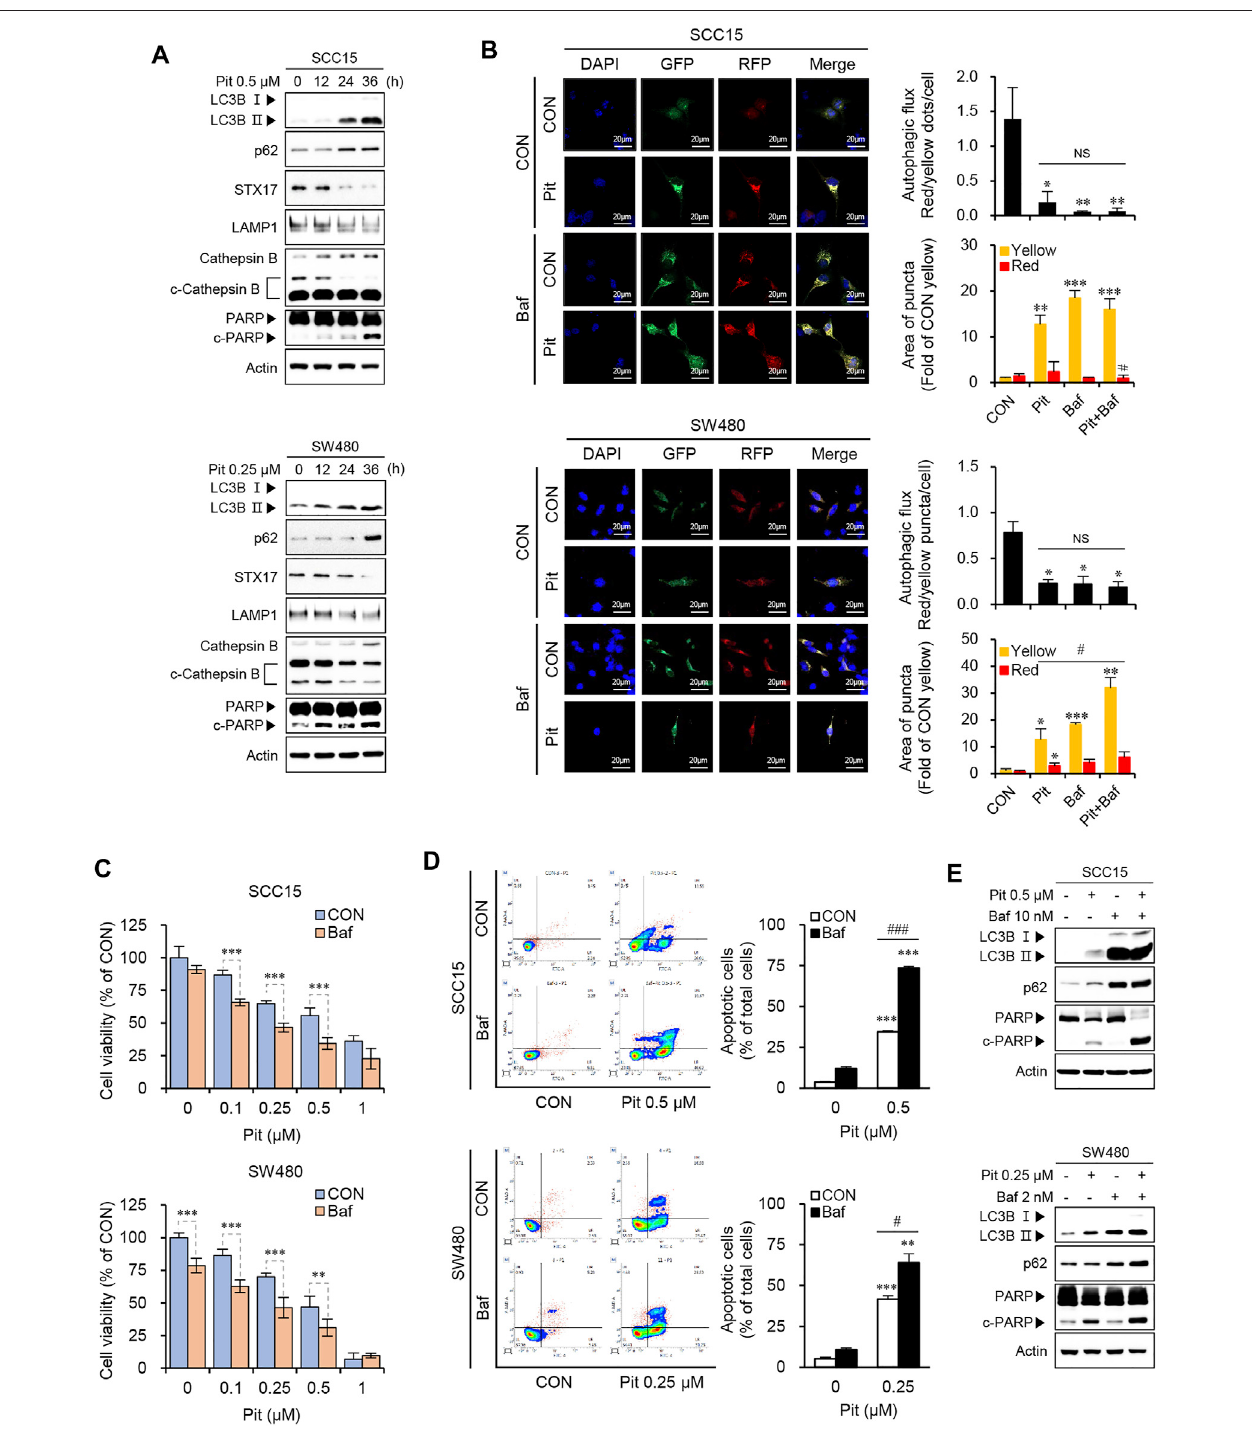
FIGURE 3 | Pitavastatin induces apoptosis through the blockade of autophagy fl ux. (A) Cells were treated with 0.5 µM of pitavastatin as indicated and the protein expressions were measured by western blot analyses. (B) After transfection of cells with mCherry-GFP-LC3 plasmid, cells were treated with pitavastatin or Ba fi lomycin A1 for 36 h. The formation of autophagosomes (yellow puncta), and autolysosomes (only red puncta) were analyzed by confocal microscopy. The histograms show the quanti fi cation of yellow and red puncta; quantitation was performed using the ImageJ software. Statistical analysis was performed using the Student ’ s t -test. Error barsrepresentmean±SD( n =3).* p < 0.05;** p < 0.01;*** p < 0.001; # p < 0.05. (C) CellsweretreatedwithpitavastatinandBa fi lomycinA1togetherfor48 h,andthecell viabilitywasmeasuredbyusingtheCytoTox-Glocytotoxicityassay.Statisticalanalysiswasperformedbytwo-wayANOVA.Errorbarsrepresentmean±SD( n =4).** p <